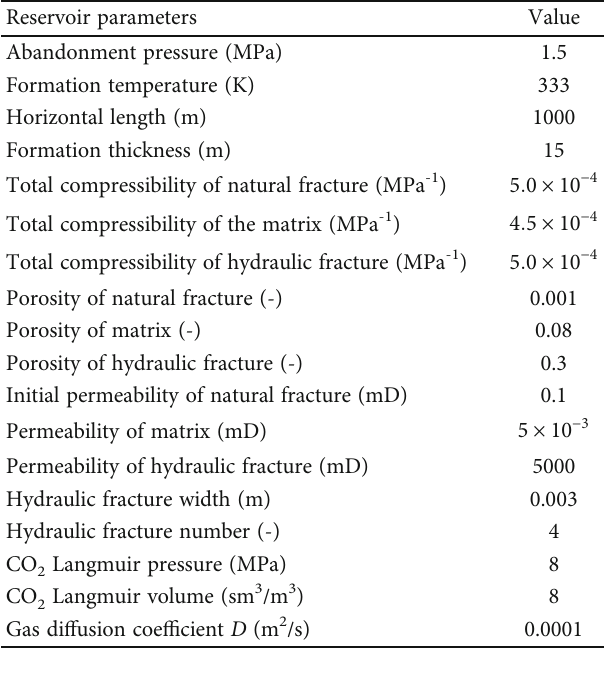
Table 1: Reservoir parameters and production parameters (data from the literature [24]).